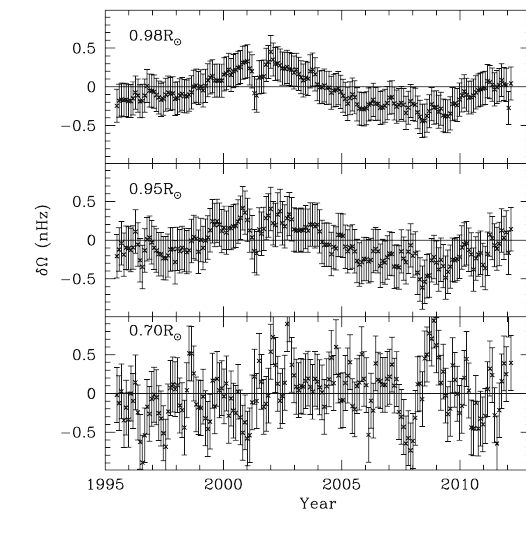
Fig. 35 The change in the latitudinally independent component of the solar rotation rate plotted as a function of